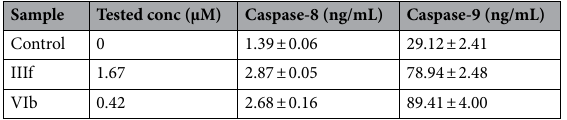
Table 8. Effects of ( IIIf ) and ( VIb ) on Caspase-8 and 9 protein expression in MCF-7 cells.